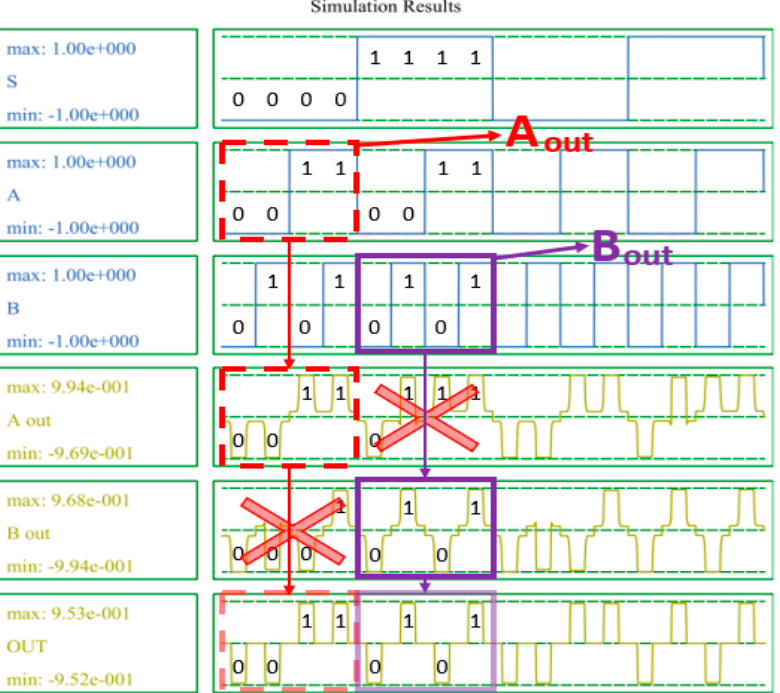
Figure 15. Simulation result of the proposed 2-to-1 Mux.